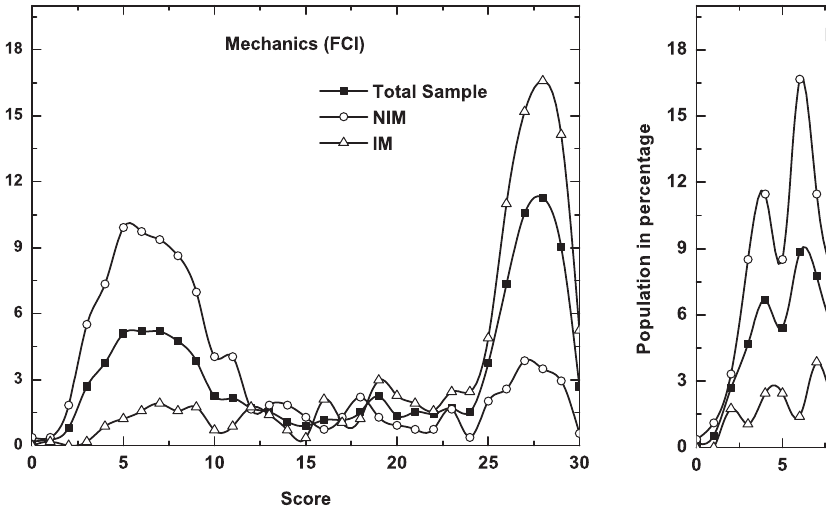
FIG. 1. Performance of Indian students in the FCI [19], a standardized test in mechanics consisting of 30 questions. The graph is first plotted for the whole sample and then separately for the NIM and the IM. Note the bimodality in the plot for the whole sample.